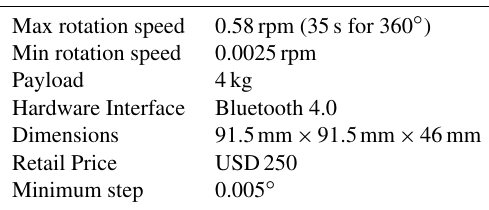
Table 1. Velodyne VLP-16. Table 2. Syrp